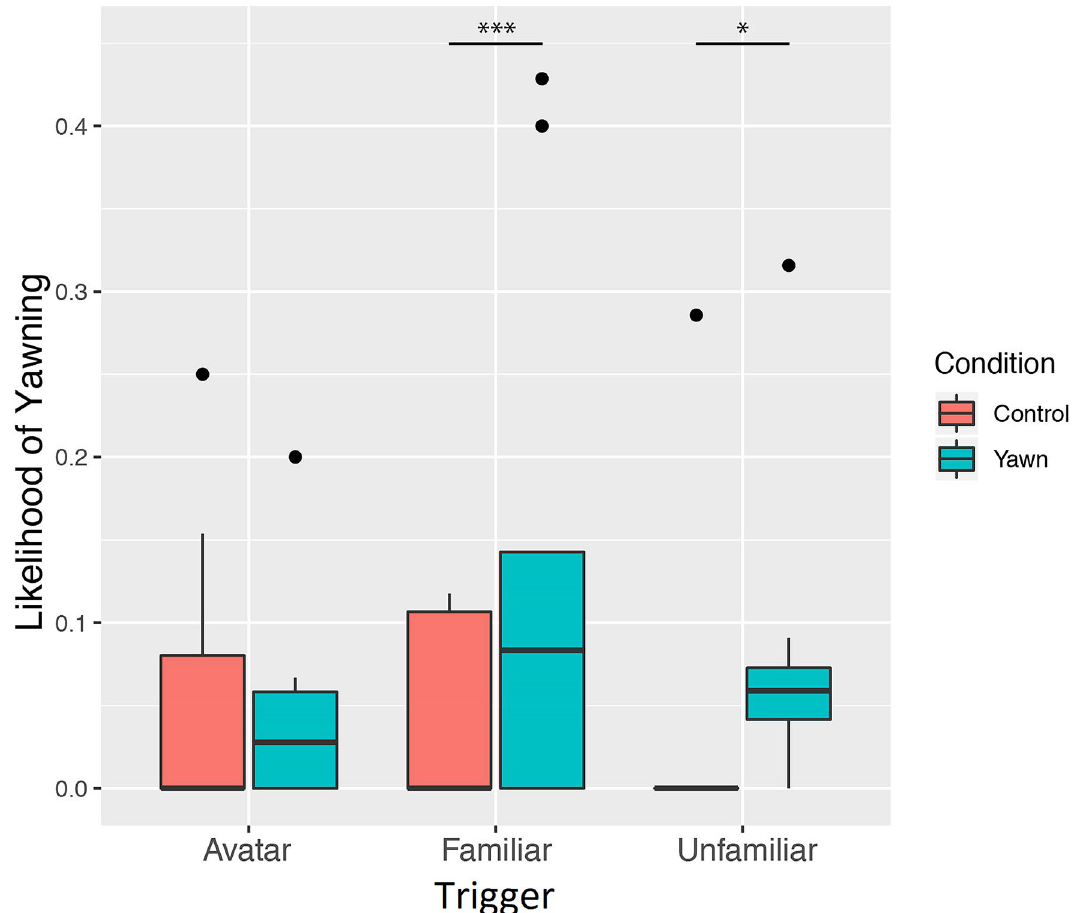
Figure 2. Likelihood of yawning across conditions and triggers. Boxplots show the median (solid line), 25th-75th percentile (box) and the largest and smallest value within 1.5 times the interquartile ranges respectively (whiskers). Dots reflect